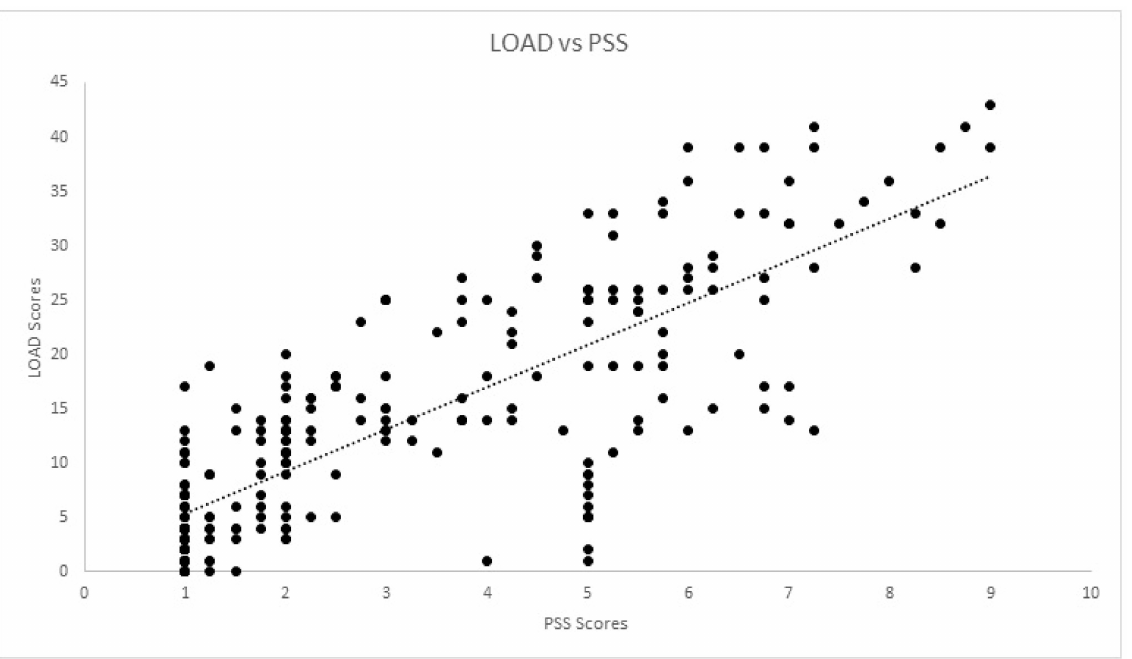
Figure 4. Scatterplot of LOAD (Liverpool Osteoarthritis in Dogs) and PSS (Pain Severity Score) in the longitudinal cohort. A significant strong correlation was observed (r = − 0.807, p <